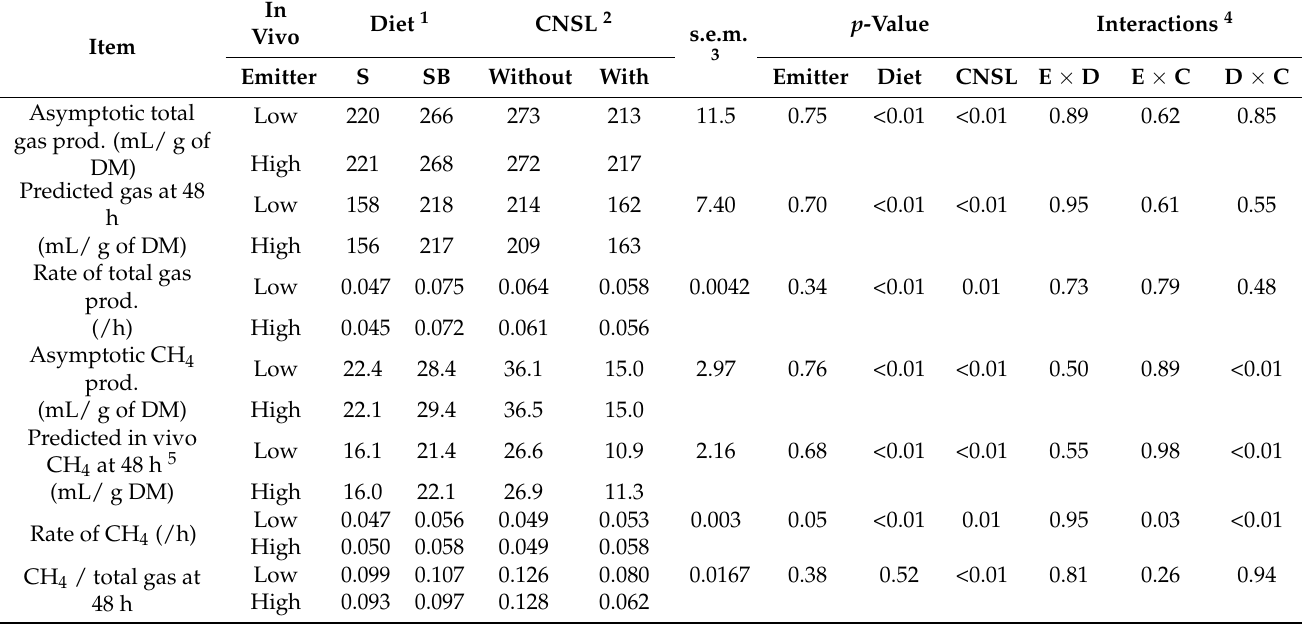
Table 4. The effects of rumen fluid inoculum (low vs. high emitters in vivo) on total gas production, predicted values of in vivo CH 4 production, predicted CH 4 production based on stoichiometric relationship with volatile fatty acids (VFA), and their kinetic parameters after 48-h incubation ( n = 7 runs/ pairs of